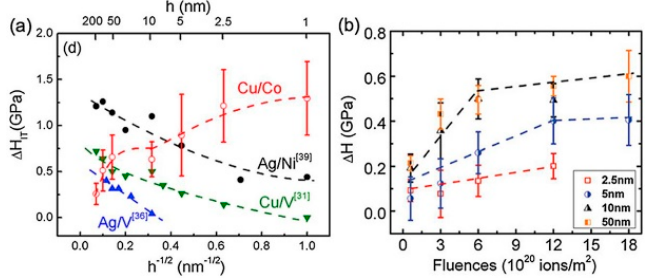
Figure 18. ( a ) Irradiation hardening in He ions irradiated Ag/V, Ag/Ni, Cu/V multilayers scaling with layer thickness. ( b ) Fluence dependence of irradiation hardening in He ion irradiated Cu/V multilayers